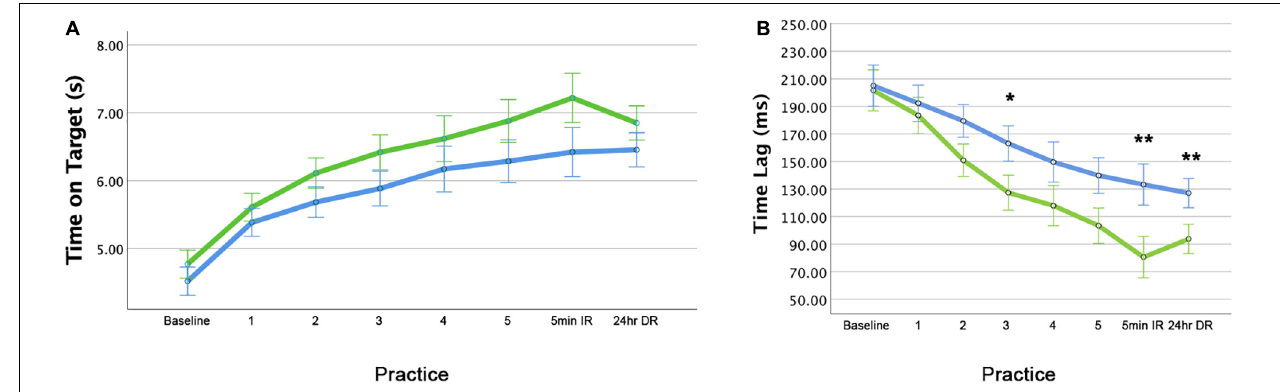
FIGURE 6 | Motivational statements improve task performance. Motivational statements improve (A) time on target and (B) temporal accuracy (time lag) performance during practice and retention (motivation plus feedback = green, feedback only = blue). * p < 0.05, ** p < 0.01 for between group comparisons. Note that the significance level was corrected for multiple comparisons for practice blocks. IR, immediate retention; DR, delayed retention. Error bars = ± 1 standard error.